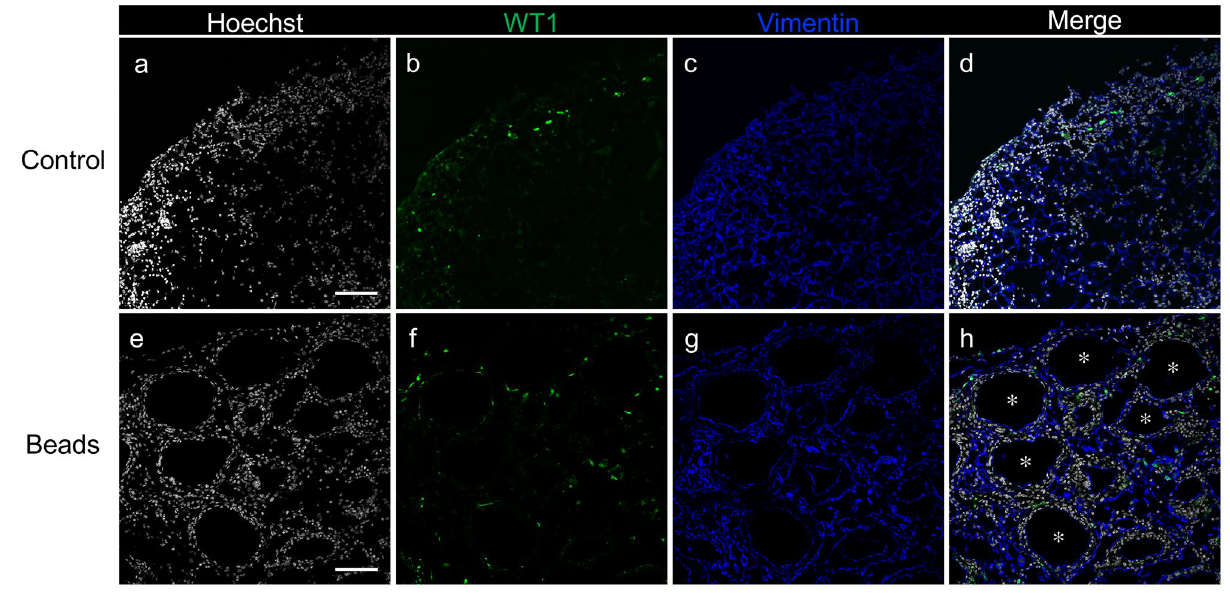
Figure 2. Representative confocal images of the omenta of control and bead-injected WT1 CreER2T/ + and Rosa2 6 loxp-stop-loxp-YFP/ + mice. Eight-week-old mice were intraperitoneally injected with tamoxifen and polyacrylamide beads. Mice were sacrificed 7 days after injection. Images ( a – d ) show the omentum of the control mouse, and ( e – h ) show the omentum of the bead-injected mouse. ( a and e) Hoechst nuclear staining. ( b and f ) Expression pattern of WT1 in the same field as ( a) and ( e) , respectively. ( c and g ) Expression pattern of vimentin in the same field as ( a ) and ( e ), respectively. ( d and h ) Merged images of ( a – c ) and ( e – g ), respectively. Asterisks ( h ) indicate polyacrylamide beads. Scale bars = 100